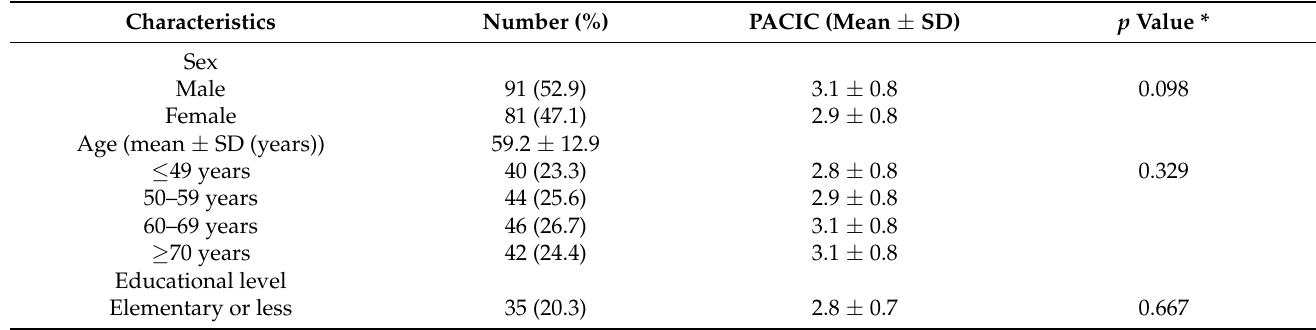
Table 1. Patient characteristics and overall PACIC